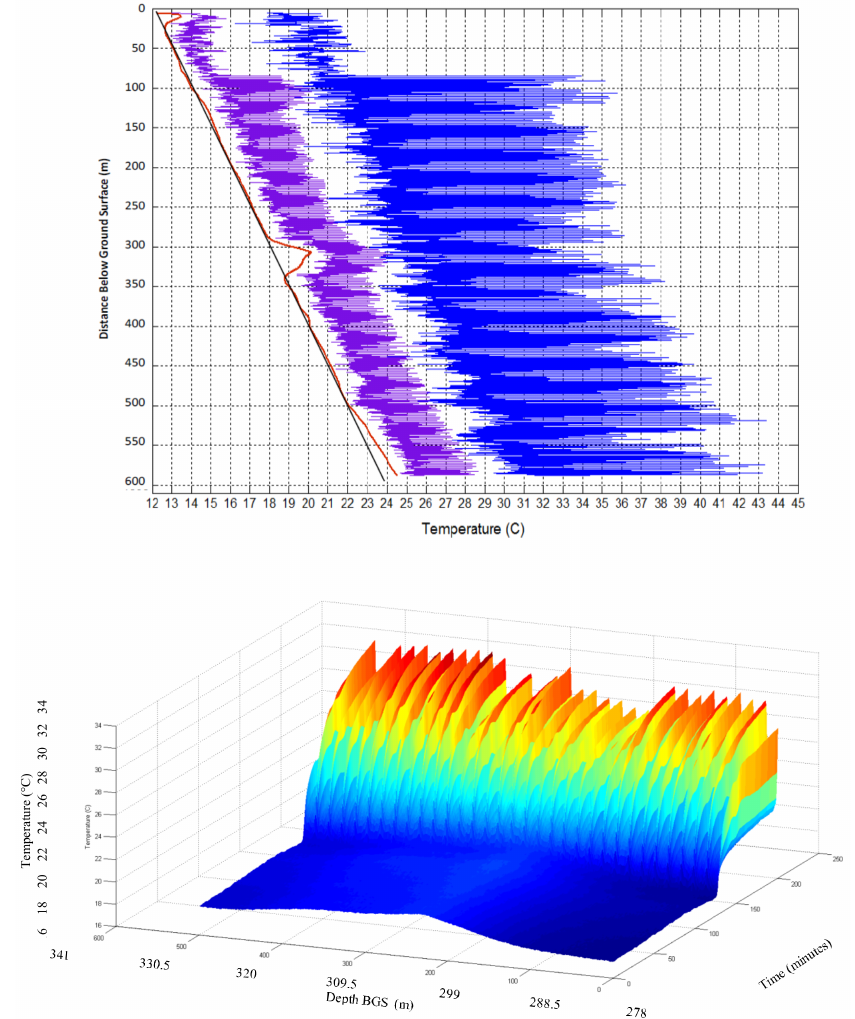
Figure 6. Temperature change after energizing heaters. Upper : Temperature prior to the heat pulse (red), 4 min after energizing the intermittent heater (purple), and 24 h after start of heating (blue). Lower : “Close-up” view of heating of 50 m portion of sensor. 413 to 490 bgs Brightly colored “fins” that appear with heating are locations of concentrated heat (“dots”). The slightly elevated ridge prior to heating is the anomaly seen in prior to heating from previous drilling activity in the